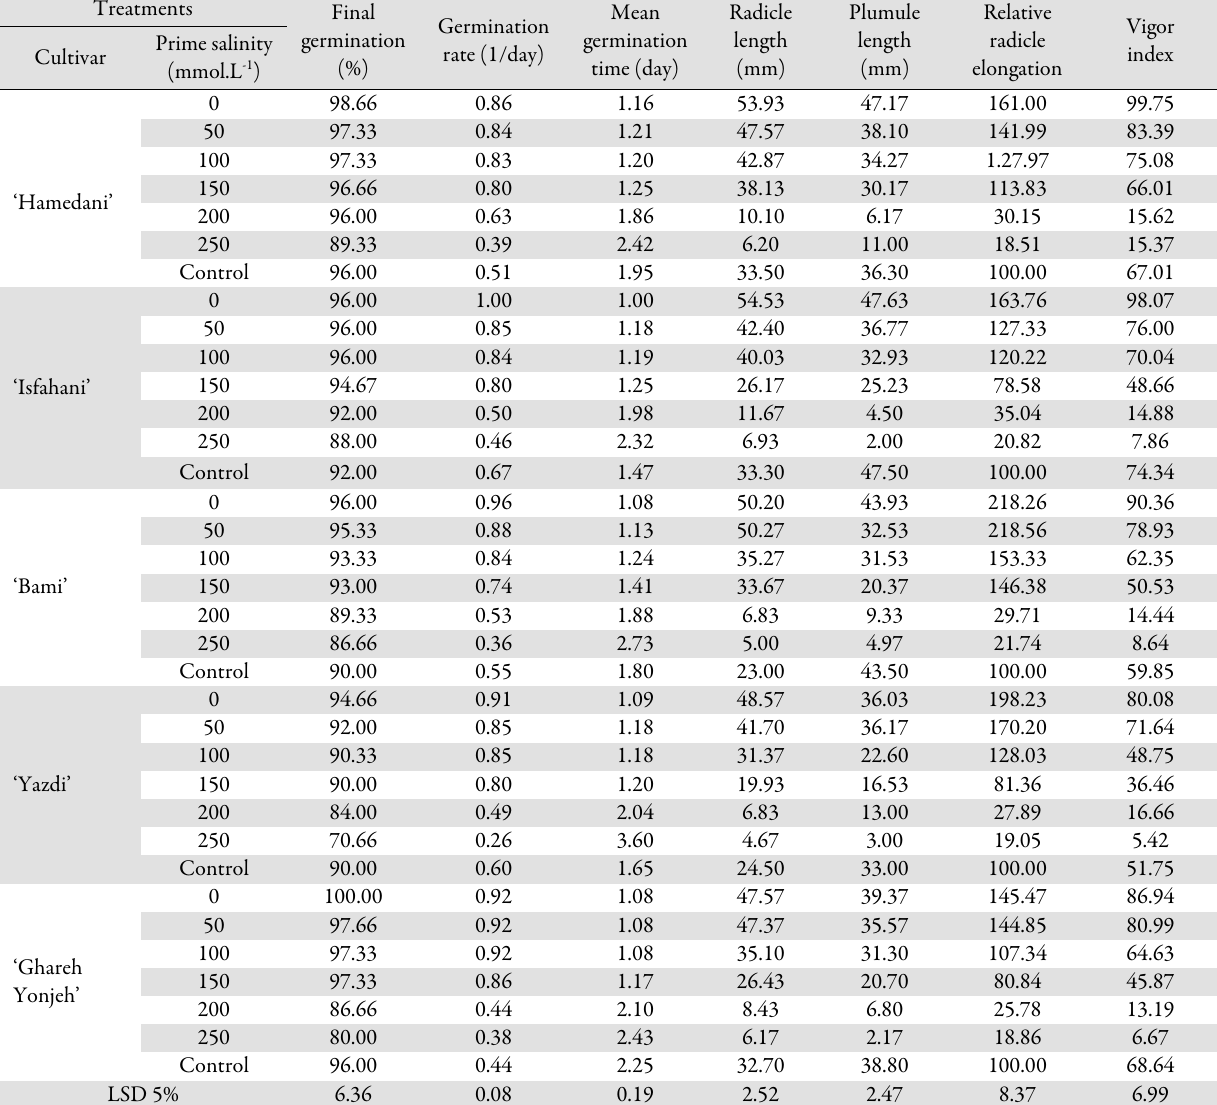
Table 2. Means interaction effects of hydro-priming-salinity and cultivars in studied traits